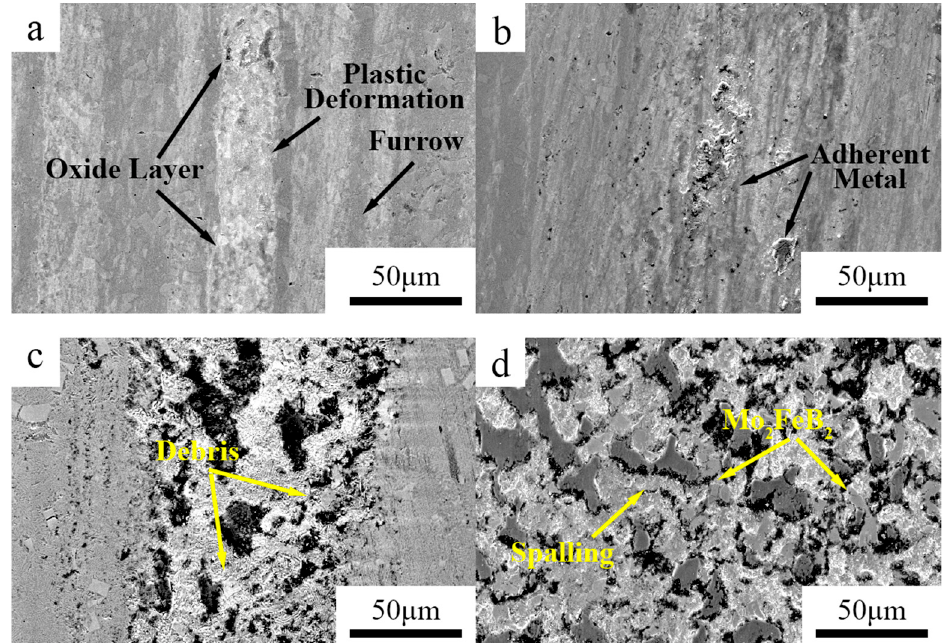
Figure 12. SEM images of worn surfaces on the Fe–Cr–Mo–Ni–B coating under different load: ( a ) 20 N; ( b ) 30 N; ( c ) 40 N; ( d ) 50 N.